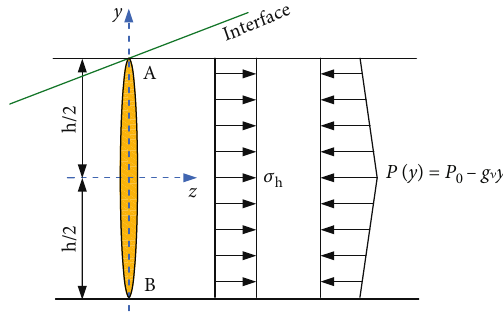
Figure 2: Stress distribution of the fracture pro fi